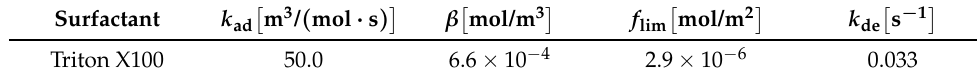
Table 3. Physical properties as a soluble surfactant of Triton X-100.